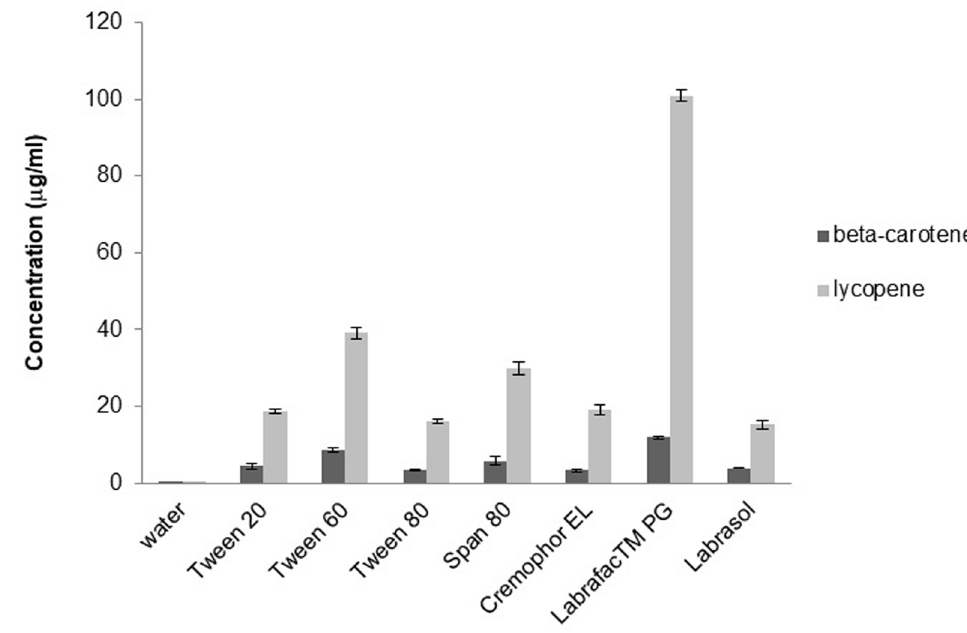
FIGURE 1 - Concentration of beta-carotene and lycopene solubilized in various surfactants (mean ± SD, n = 3).